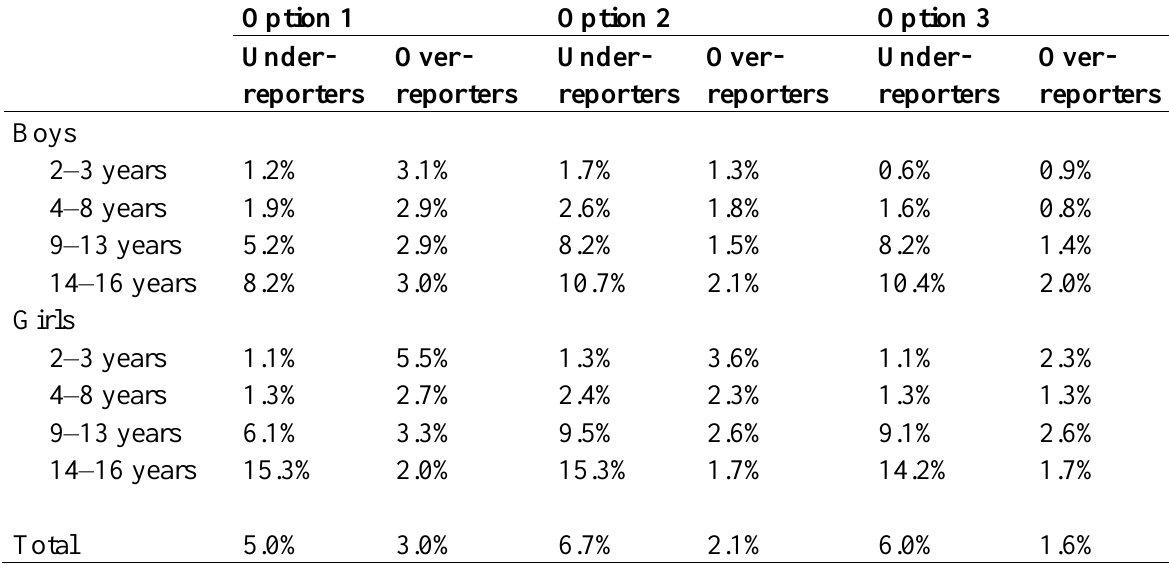
Table 1. Comparison of prevalence of misreporters * based on three criteria options ( n = 4826)